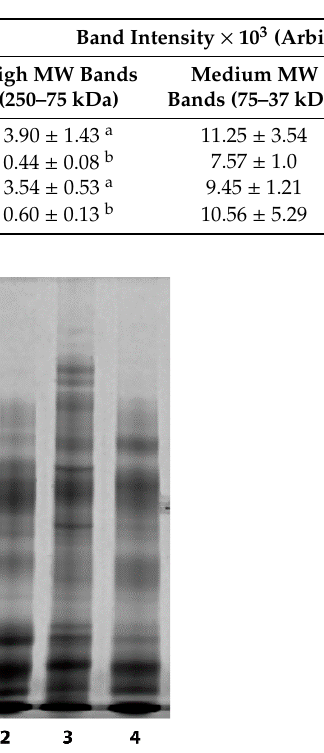
Table 1. Protein concentration (mg/mL, n = 12 seminal plasma samples for seasonal rams, and n = 24 seminal plasma samples for non-seasonal) and densitometric quantification (×10 3 arbitrary units, n = 4 seminal plasma samples) of high, medium and low molecular weight (MW) bands of seminal plasma from intact and vasectomized rams subjected to a temperate (seasonal rams) or equatorial (non-seasonal rams) photoperiod. Results are shown as mean ± SEM. a , b indicate p < 0.001.